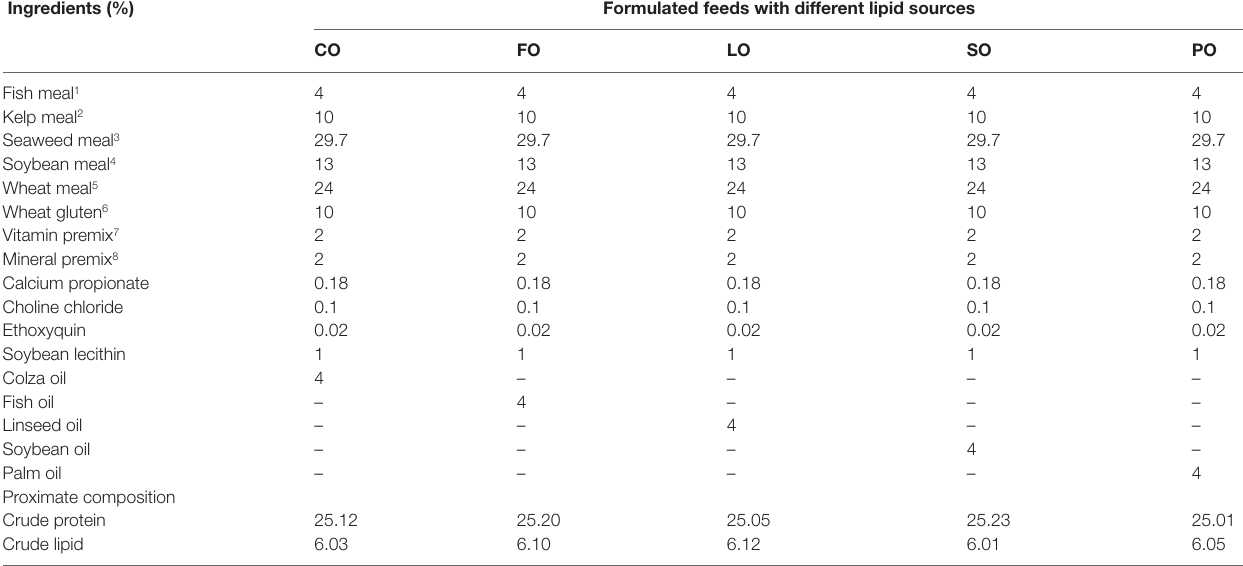
TABLE 1 | Formulation and proximate composition of the experimental diets (% dry weight). Ingredients (%) Formulated feeds with different lipid